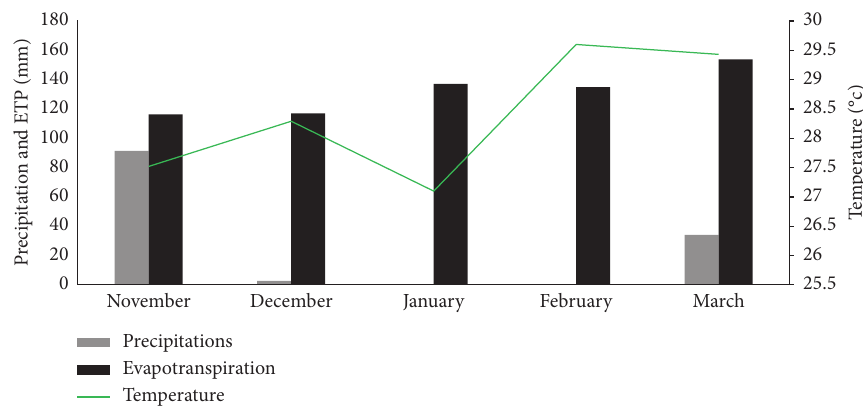
Figure 1: Climate data in the